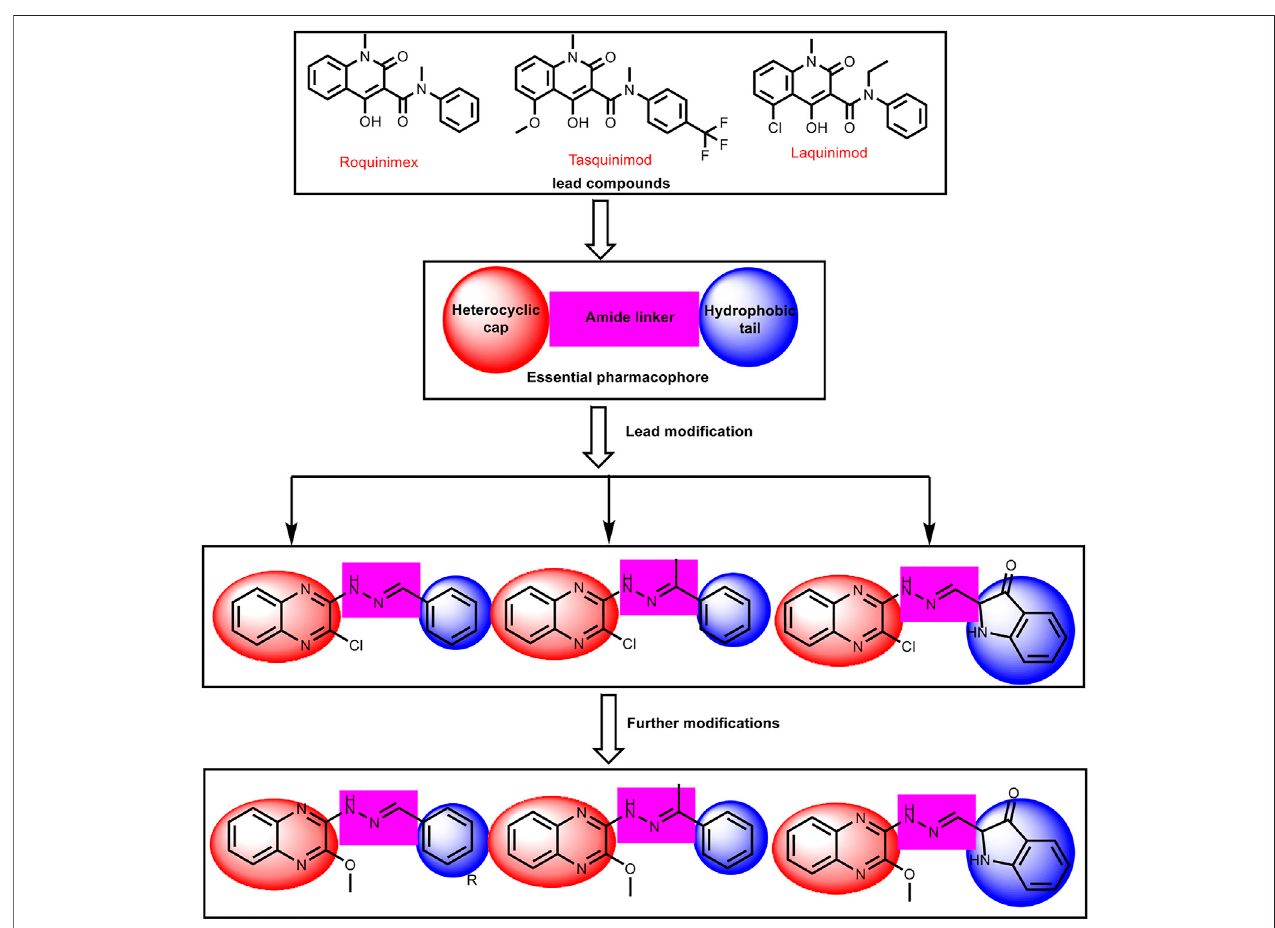
FIGURE 3 | The basic structural requirements for roquinimex, tasquinimod, and laquinimod as reported HDAC inhibitors and their existence in our newly synthesized compounds.